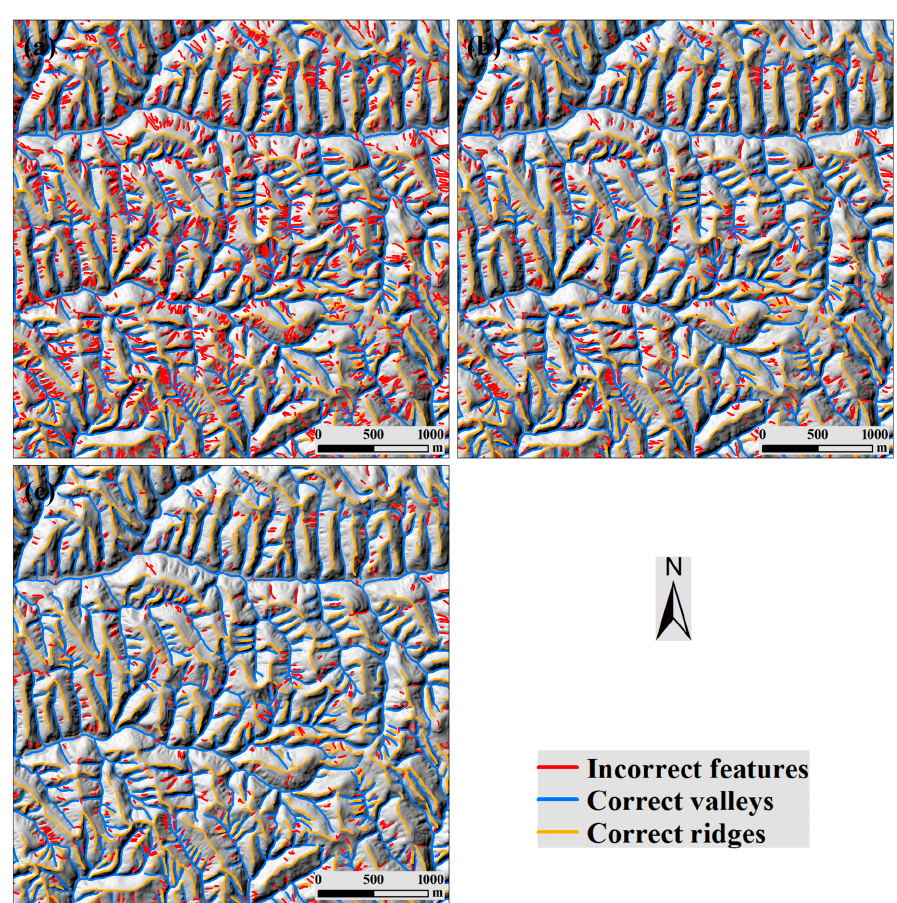
14 Figure 14. Extraction of ridges and valleys with di ff erent thresholds using the SoA derived from the vector method in Suide TA1. The thresholds are ( a ) 15, ( b ) 20, and ( c ) 25. Remote Sens. 2020 , 12 , x FOR PEER REVIEW